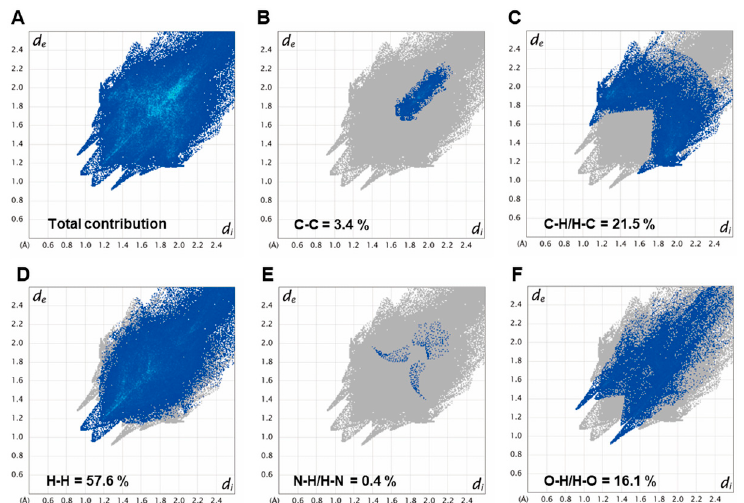
Figure 4. Two-dimensional fingerprints plots the different interactions in the structure of BY1.